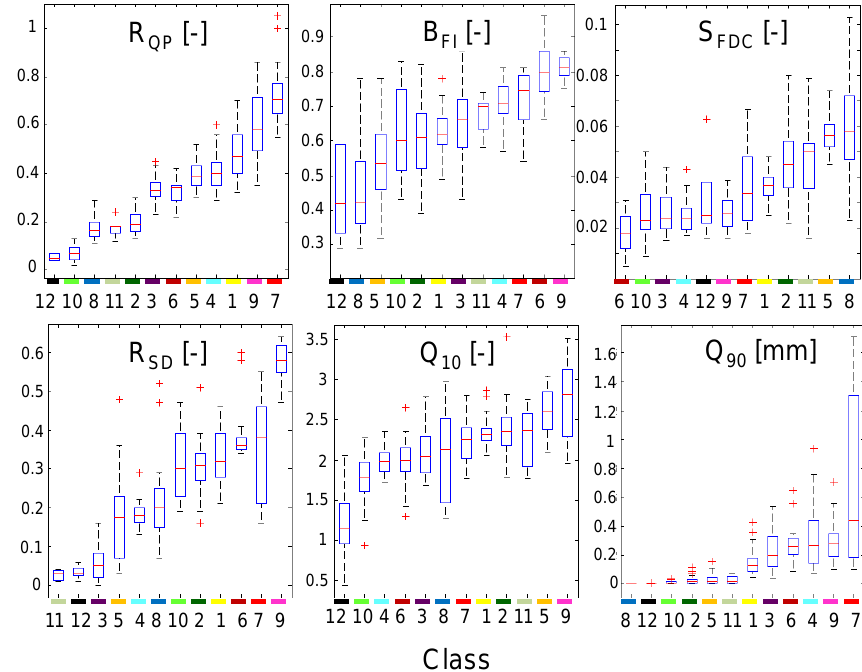
Fig. 2. Box–whisker plots of signature characteristics for the different clusters.